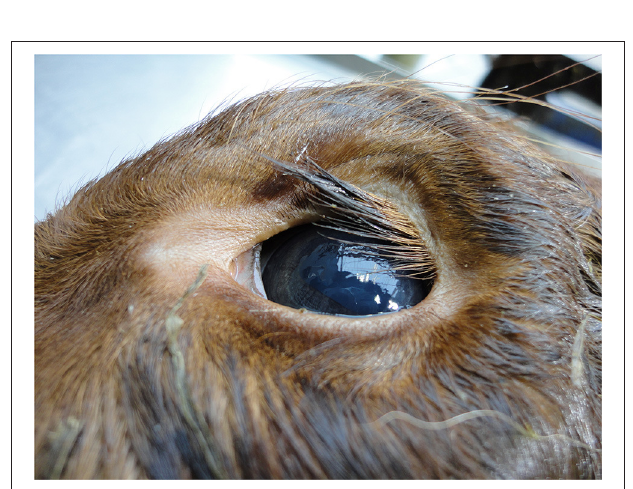
FIGURE 6 | Ocular discharge in a